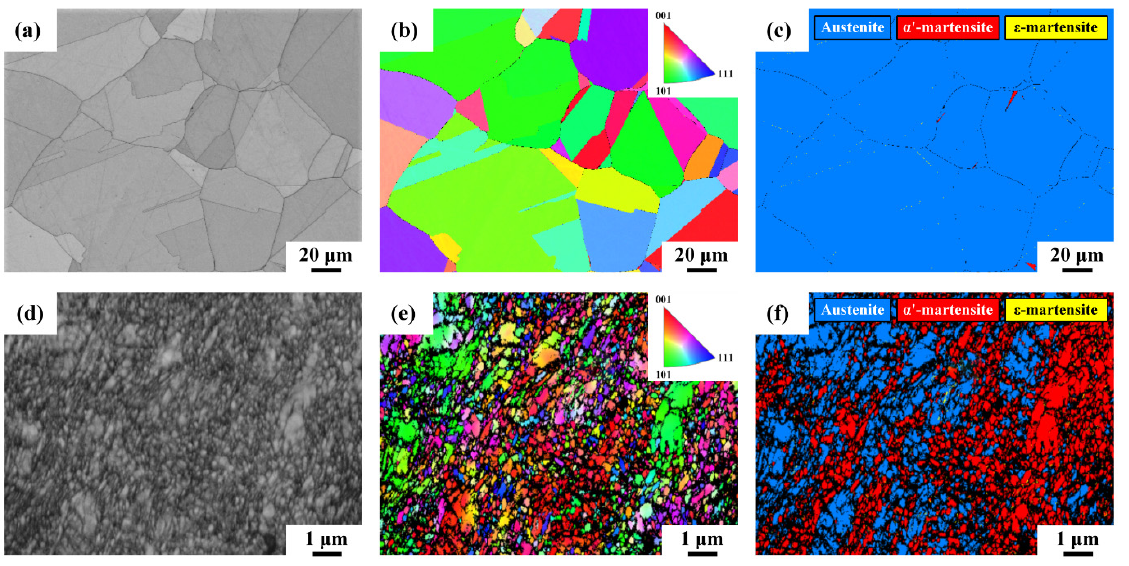
Figure 6. Top surface microstructures of the 304 substrate ( a – c ) and shot-peened sample ( d – f ). ( a , d ) Scanning electron micrographs; ( b , e ) the corresponding inverse pole figure (IPF) maps; ( c , f ) EBSD phase maps.